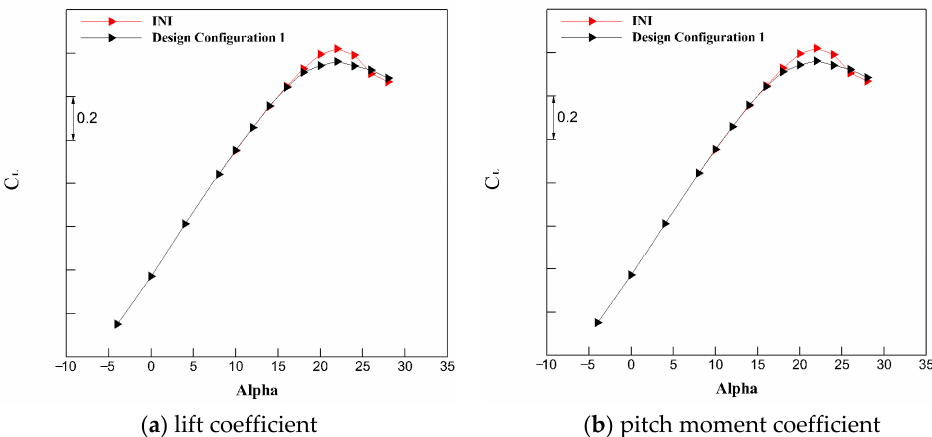
Figure 22. Aerodynamic coefficients of INI and Design Configuration 1.